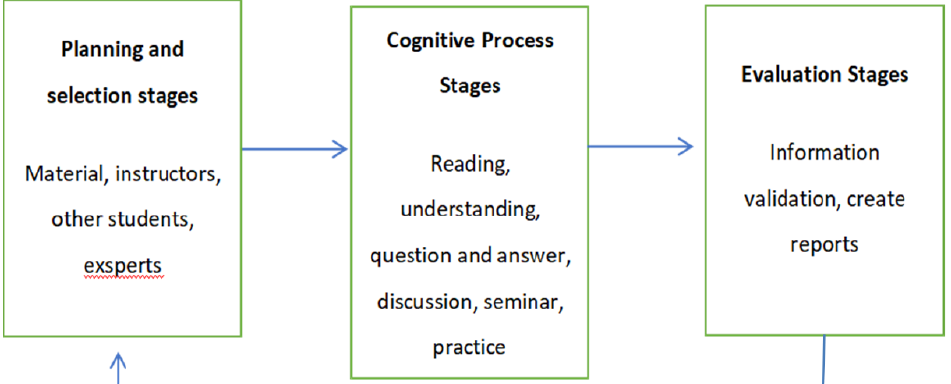
Figure 1. Stages of Connectivity in online learning